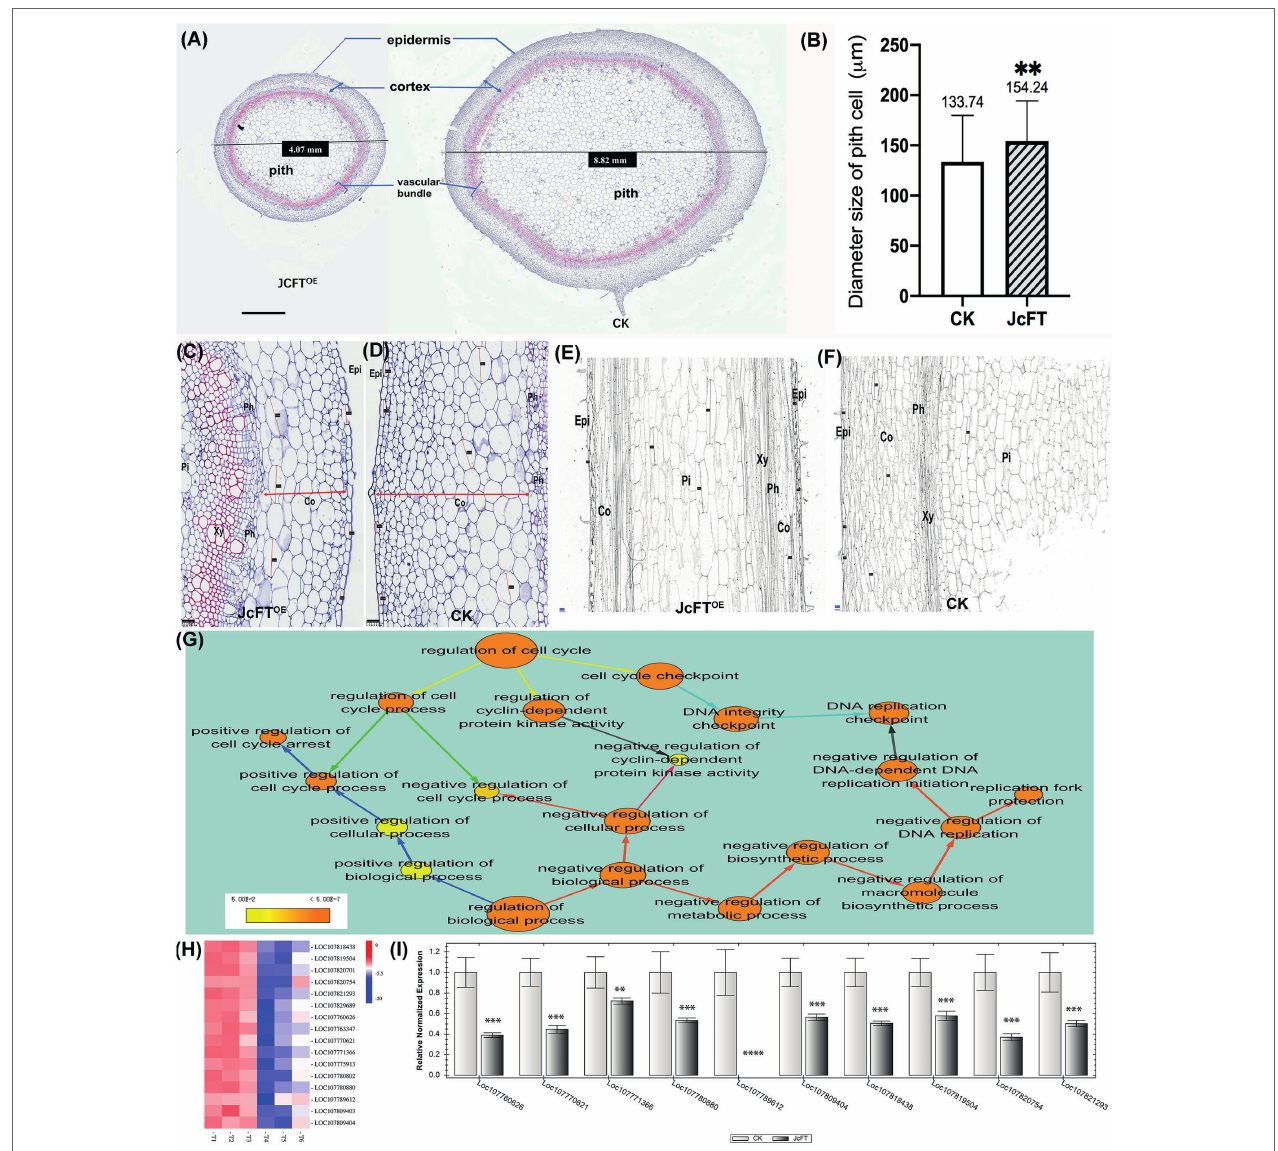
FIGURE 7 | Comparison of stem cell morphology, number, and size and cell cycle regulation between JcFT OE and control (CK) plants. (A) Stem cross sections of JcFT OE and control plants (The values in the central boxes represented the diameter size of the samples, scale bar = 1 mm). (B) Average size of pith cells in JcFT OE and control plants (The values represented mean, the vertical bars indicated standard deviation, n = 66, ** p < 0.01). (C,D) Stem cross sections (same magnification) of JcFT OE and control plants at 49 days after seeding (scale bar = 100 μ m). Double arrows indicate thickness of the cortex, and straight lines indicate larger cells in the cortex. (E,F) Stem longitudinal sections (same magnification) of JcFT OE and control plants at 49 days after seeding (scale bar = 100 μ m). (G) BiNGO annotated overrepresented GO (gene ontology) terms associated with cell cycle regulation. Color of a node represents the corrected p -value, with the scale ranging from yellow ( p = 0.01) to dark orange ( p = 0.01 × 10 − 5 ) and size of a node indicates the number of genes involved. Different colors of arrows suggested different types of enriched pathways. (H) Expression heat map of differentially expressed genes (DEGs) associated with DNA-dependent DNA replication initiation. Control samples: T1, T2, T3; JcFT OE samples: T4, T5, T6. Blue indicates a decrease in gene expression; red indicates an increase in gene expression. (I) Reverse-transcription qPCR of 10 DEGs associated with DNA-dependent DNA replication initiation (bars represented gene expression mean and standard error of mean, n = 3, ** p < 0.01, *** p < 0.001, **** p < 0.0001, and the corresponding gene accession number was under the bars.). Epi: epidermis; Co: cortex; Ph: phloem; Xy: xylem; Pi: